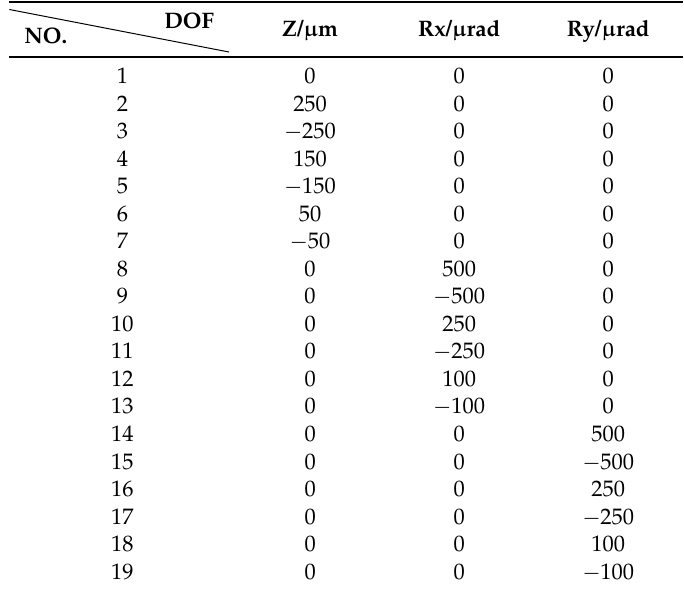
Table 6. Vertical movement setting.